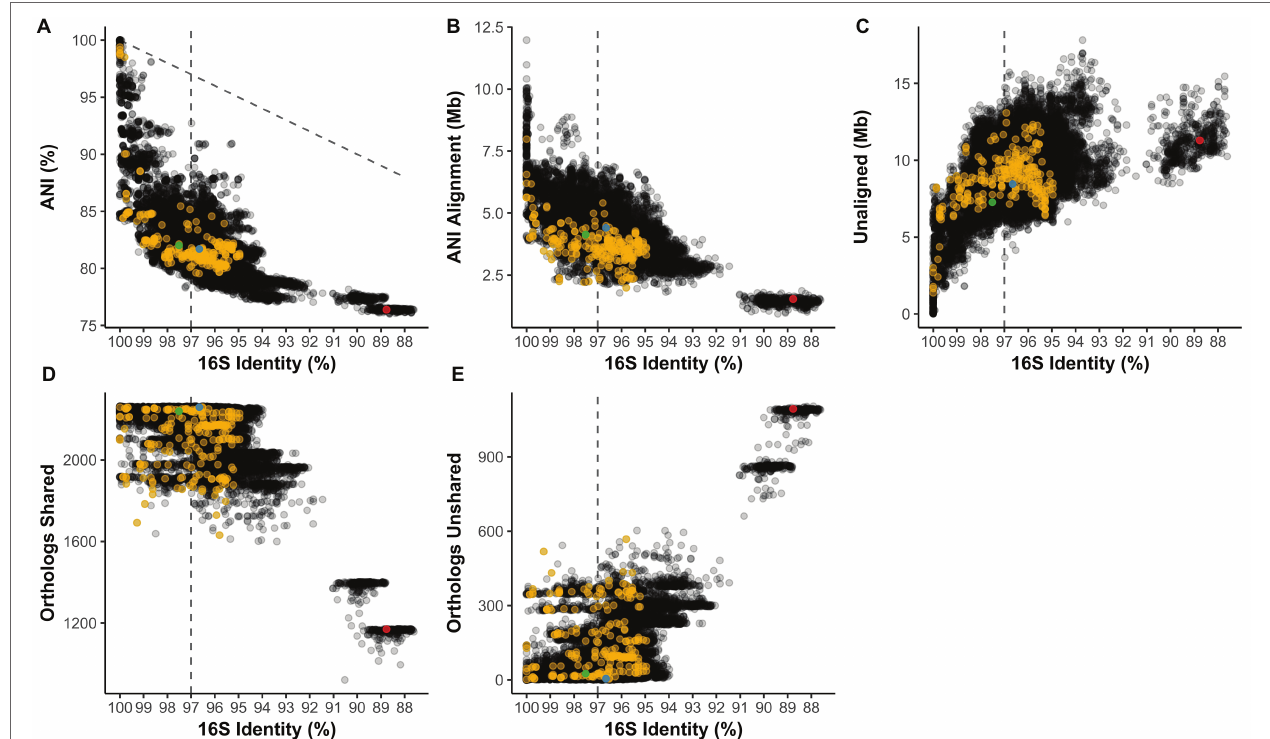
FIGURE 3 | (A) Average nucleotide identity (ANI) compared to 16S rRNA gene identity in pairwise comparisons of Streptomyces . Diagonal line = 1:1 relationship. Length of the (B) ANI alignment length and (C) unaligned portions of both genomes compared to 16S identity in the same pairwise comparisons. Number of (D) shared and (E) unshared orthologs versus 16S identity. (A–E) Vertical line = 97% 16S identity; yellow = pairwise comparisons also in the subset from Figures 5, 6 . Green = Clade II S. coelicolor A3(2) vs. Clade II S. albus J1074; blue = Clade II S. coelicolor A3(2) vs. Clade I S. griseus NBRC 13350; red = Clade II S. coelicolor A3(2) vs. Pseudonocardia sp.